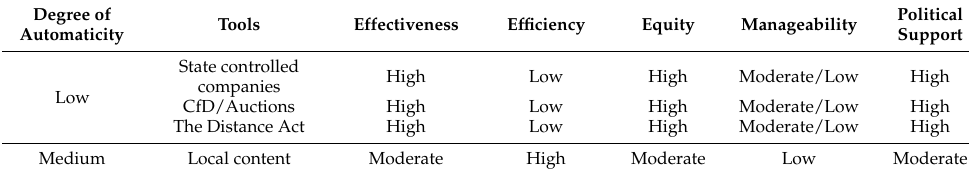
Table 6. Degree of automaticity.